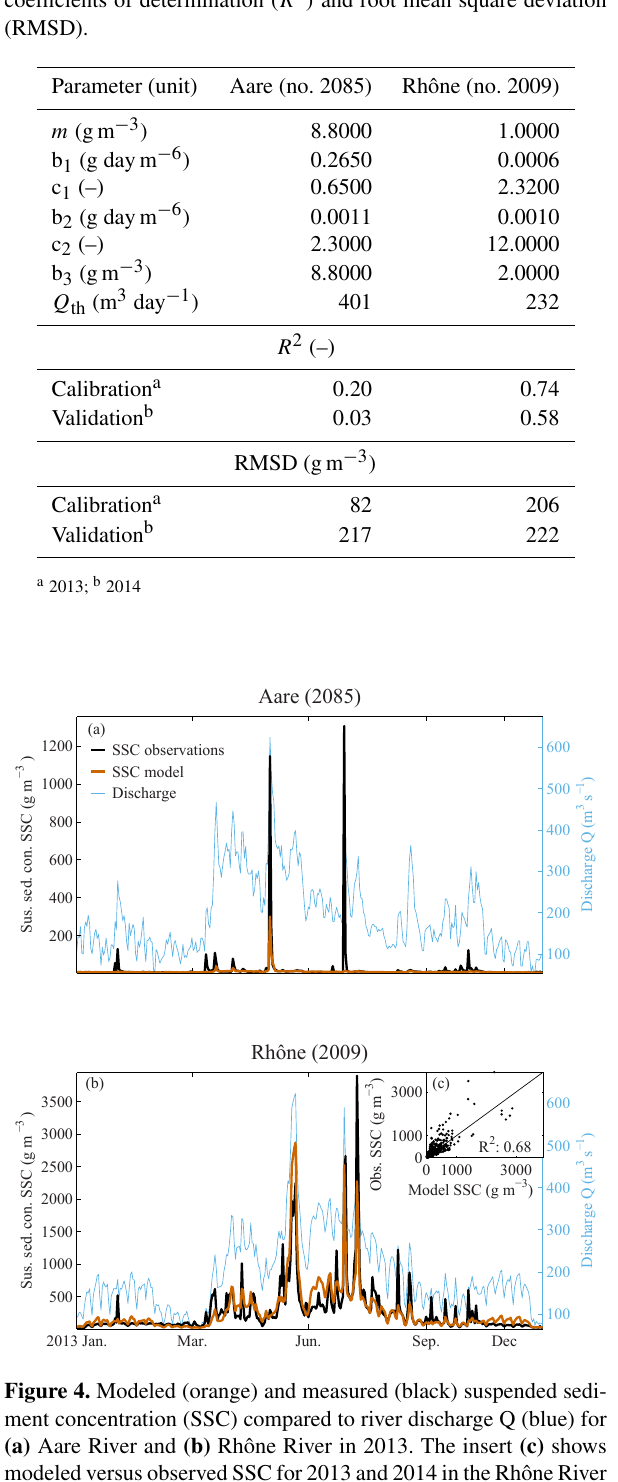
Table 3. One-dimensional lake model SIMSTRAT best-fit parame- ters and model performance statistics reported as vertical volume- weighted averaged root mean square deviation